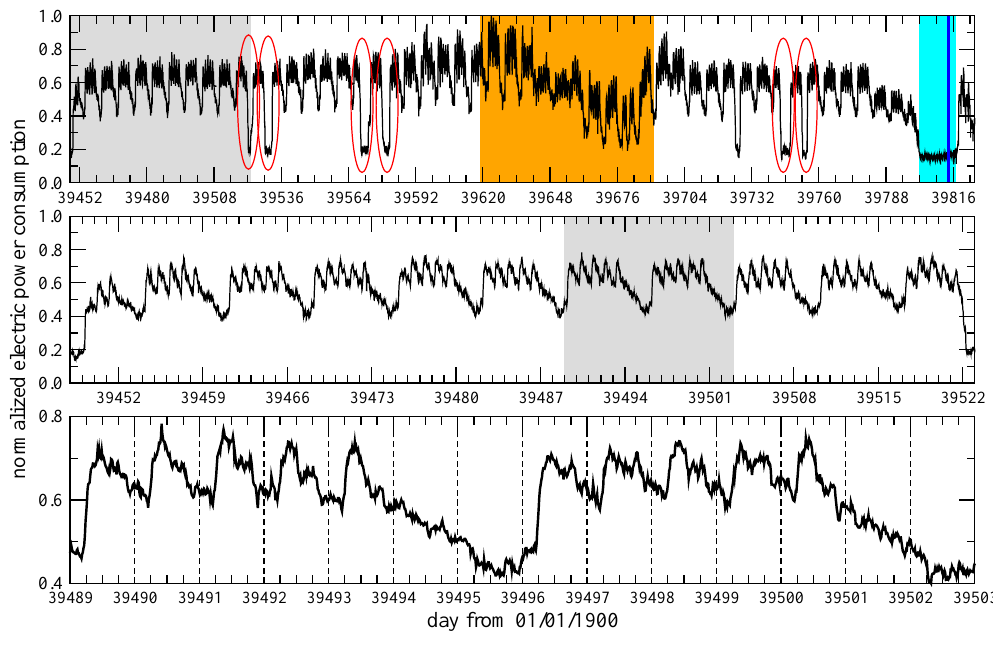
Figure 4. Relative electric power consumption (instantaneous value normalized by the mea- sured maximum) as a function of time in the year of 2008 (top). Gray shading indicates the period magnified in the middle panel. The orange interval is the main holidays season (from mid-June to end August), light-blue section shows the Christmas-New Year break. The el- lipses denote major national holidays (15th of March, Easter, 1st of May, Pentecost, 23th of October, and Hallowmas). The gray shading in the middle panel denotes the two weeks magnified at the